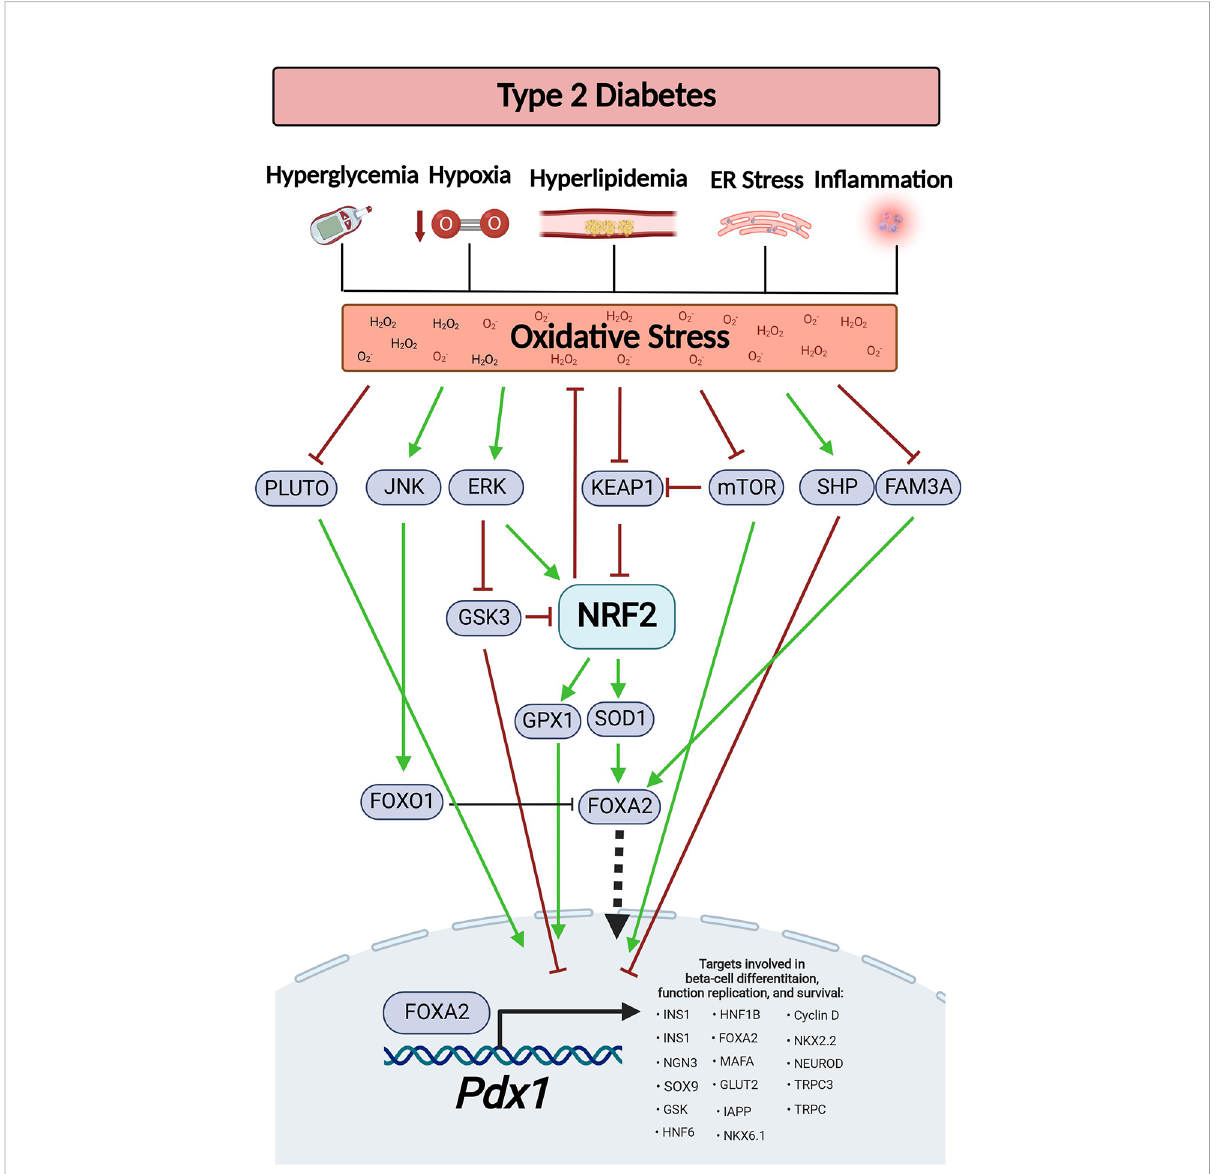
FIGURE 1 Oxidative stress-dependent pathways affect Pdx1 levels during diabetes. Type-2 diabetes is associated with various pathological conditions that generate ROS, such as hyperglycemia, hyperlipidemia, hypoxia, in fl ammation, and ER stress. This results in oxidative stress. Oxidative stress reduces the expression level of PLUTO lncRNA, stimulates JNK-dependent FOXO1 activation, inhibits mTOCR signaling, increases SHP expression and reduces FAM3A levels, all of which results in decreased PDX1 levels. On the other hand, in order to maintain ROS at appropriate levels, oxidative stress also serves as a signal for Nrf2 activation by inhibition of Keap1 and by activation of the ERK signaling. This results in increased expression of the Nrf2 target genes, Sod1 and Gpx, which restore PDX1 levels. This fi gure was generated using